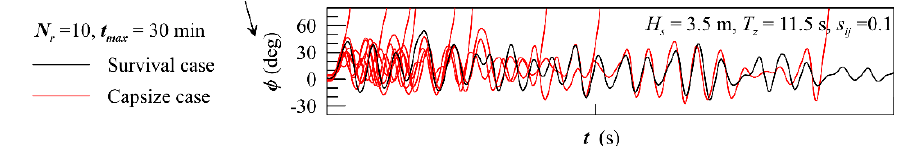
Figure 3. Example of ten realisations of the same damage in irregular waves for a cruise ship.